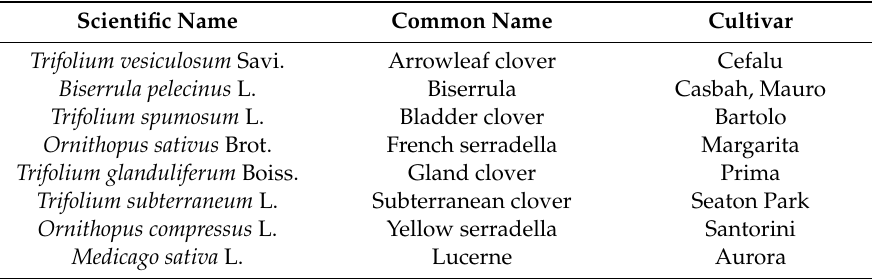
Table 4. Scientific, common, and cultivar names of annual pasture legumes evaluated in this study.